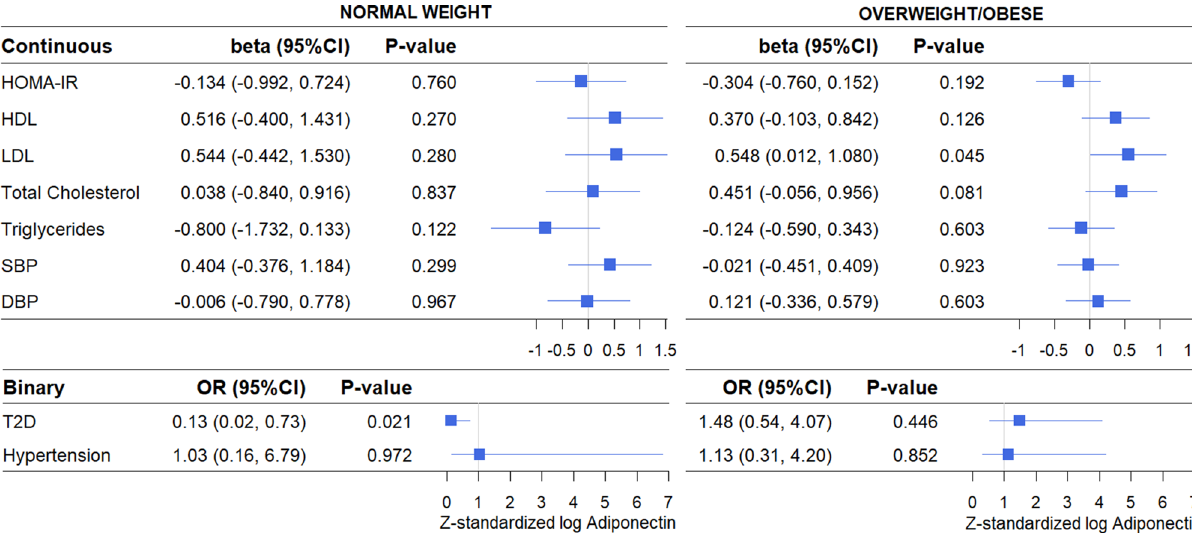
Figure 4. Causal associations between adiponectin and cardiometabolic outcomes in normal weight and overweight/obese individuals using the two-stage least-squares method. Values are presented are adjusted for age, sex, population stratification, BMI, alcohol consumption, and smoking. SBP and DBP are additionally adjusted for blood pressure medication use. HOMA-IR and Triglycerides were log transformed. All continuous variables were Z-standardized. T2D cases were excluded for all HOMA-IR